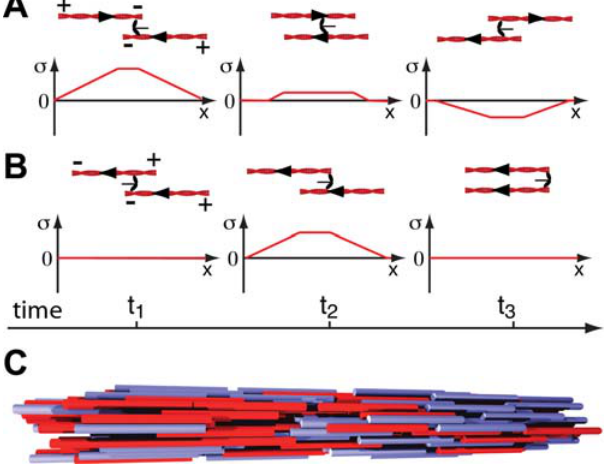
Figure 3. Stress generation in a filament bundle induced by plus end directed motor proteins. (A) Three stages of the relative sliding of two filaments of opposite orientation induced by a motor complex. During sliding, stresses result from the balance of motor forces, which are applied at the position where the motor is bound and friction forces that are distributed along the filaments. The combined stress profiles of both filaments s (x) are displayed as a function of position x . When the centers of mass of the filaments slide towards each other (i.e. the pair contracts) the stress is positive (contractile) on average. When the filaments move apart, the stress is negative. Averaging over many filament pairs and motor position in the bundle, the net stress generated by this process is zero. (B) Filaments of equal orientation tend to align their plus ends if motors stay temporarily attached to the plus end. In this case, a positive (contractile) average stress is generated. Considering the combined effects of many filament pairs in a bundle, this process contributes to contractile bundle stress. (C) Snapshot of a stochastic simulation of a bundle consisting of many filaments that interact via the processes illustrated in (A) and (B). Displayed is a typical configuration in the steady state. Filaments oriented with their plus ends to the right and left are indicated by red and blue rods, respectively. This state has on average constant density as a function of position x and generates a net contractile stress along the